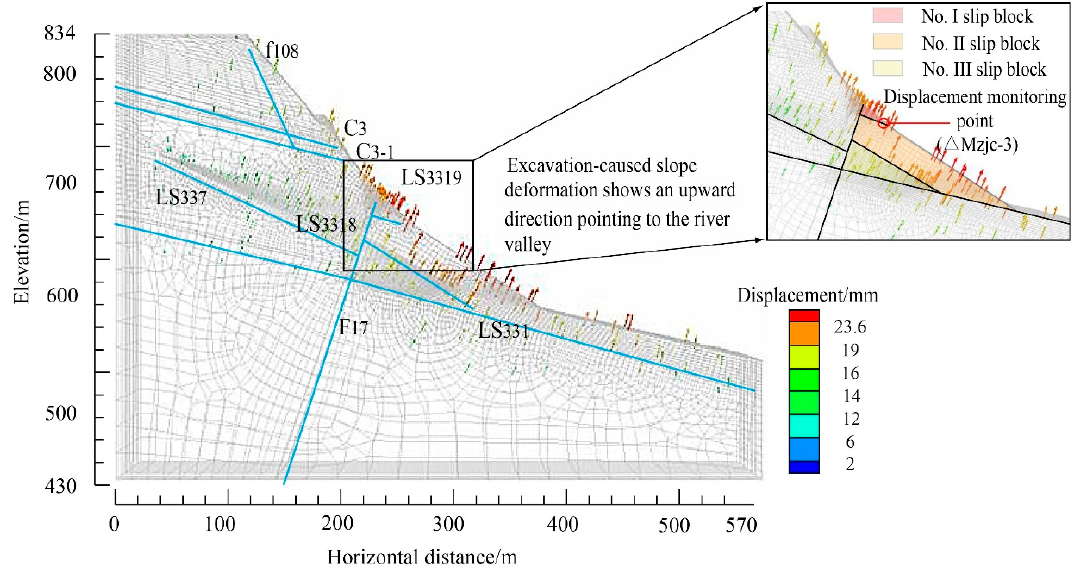
Figure 12. Displacement vector graph of the rock slope with excavation to an elevation of 550 m.